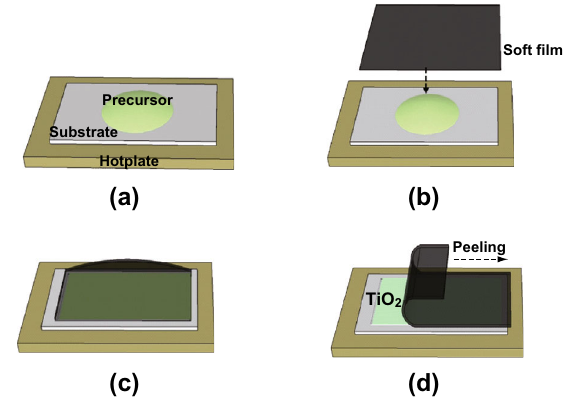
Fig. 1 Schematics of the steps in the